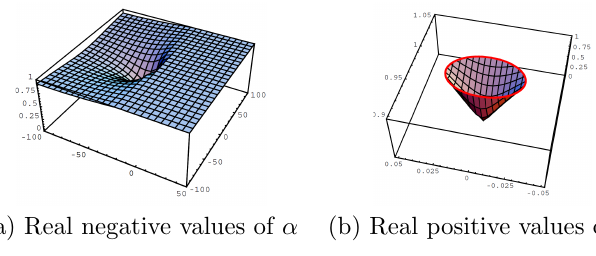
Figure 4. Stability function for z =